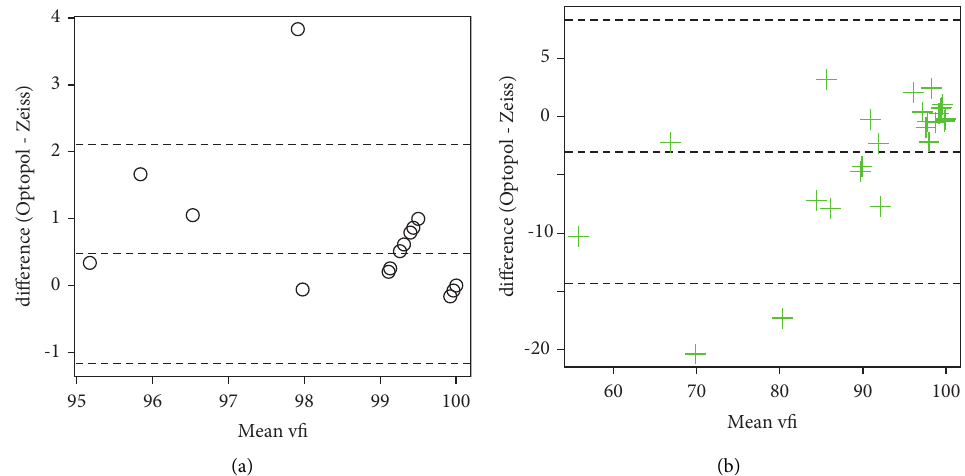
Figure 4: Bland–Altman plots for the visual field indices. For each subject, the mean of the measurement from the Zeiss and Optopol machines is taken and plotted on the x -axis. The y -axis is the difference between the Optopol and Zeiss measurements. The plot on (a) is for control subjects; the plot on (b) is for subjects with glaucoma. Table 3: Confusion matrices for Optopol’s detection that MD < − 2 as a prediction for Zeiss’ detection of the same. Normal Glaucoma Zeiss MD < − 2 The matrix on the left pertains to control subjects, and that on the right pertains to subjects with